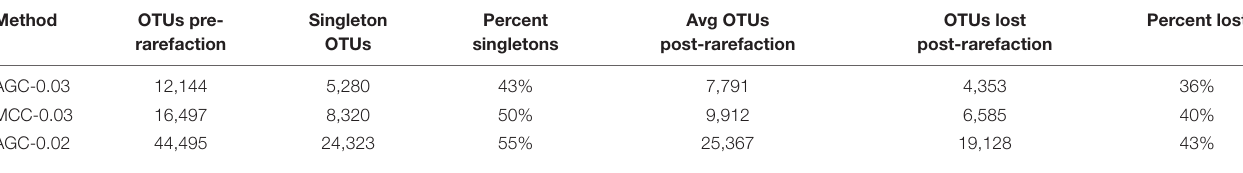
TABLE 4 | nrfA OTU table and rarefaction characteristics for each clustering